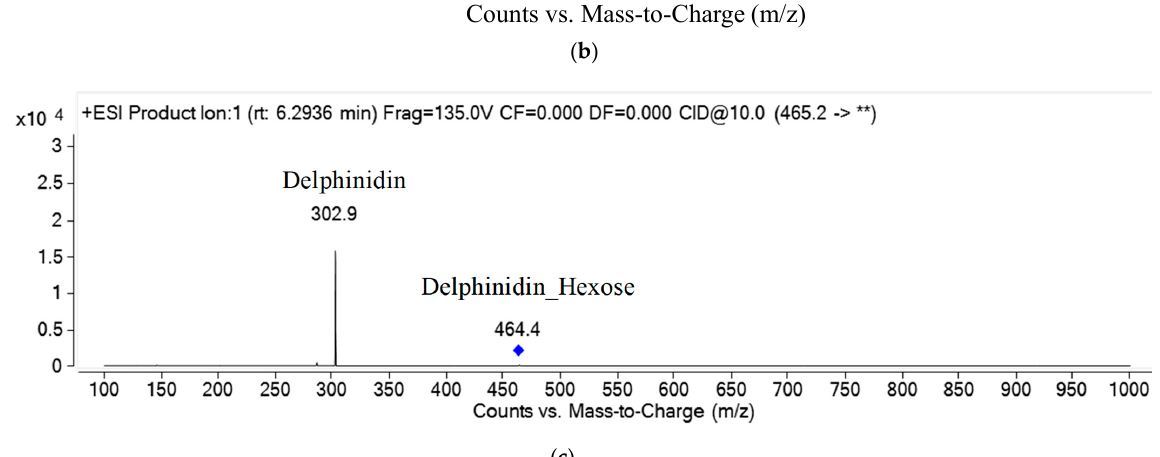
( b ) Figure 8. UPLC-MS/MS profile of five anthocyanins found in butterfly pea flower ( a ) and the comparison of their intensity ( b ). ( 1 ) Delphinidin-3-(6”-p-coumaroyl)-rutinoside, ( 2 ) Cyanidin 3-(6”-p-coumaroyl)-rutinoside, ( 3 ) Delphinidin-3-(cis-p- coumaroyl-glucoside), ( 3 ′ ) Delphinidin-3-(trans-p-coumaroyl-glucoside), ( 4 ) C yanidin-3-(p-coumaroyl)glucose and ( 5 ) Delphinidin-3-pyranoside. 3. Materials and Methods 3.1. Chemicals and Materials HPLC methanol, acetonitrile, formic acid, and acetic acid were purchased from Merck KGaA, Darmstadt, Germany. All chemicals were analytical grade. Milli-Q water (Milli-Q IQ 7003/7005, Merck, NJ, USA) was used. Butterfly pea flowers were grown at the College of Agriculture, Can Tho University, Vietnam. Butterfly pea flowers were freeze-dried in an Alpha 2–4 DL freeze dryer (Martin Christ, Germany) at − 80°C and 0.001 mbar to 3 − 5% moisture content and fi nely ground before extraction.